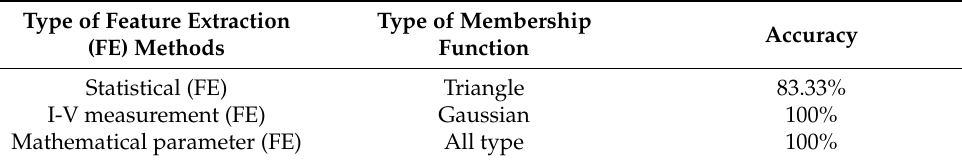
Table 4. Type of membership and accuracy for type of feature extraction